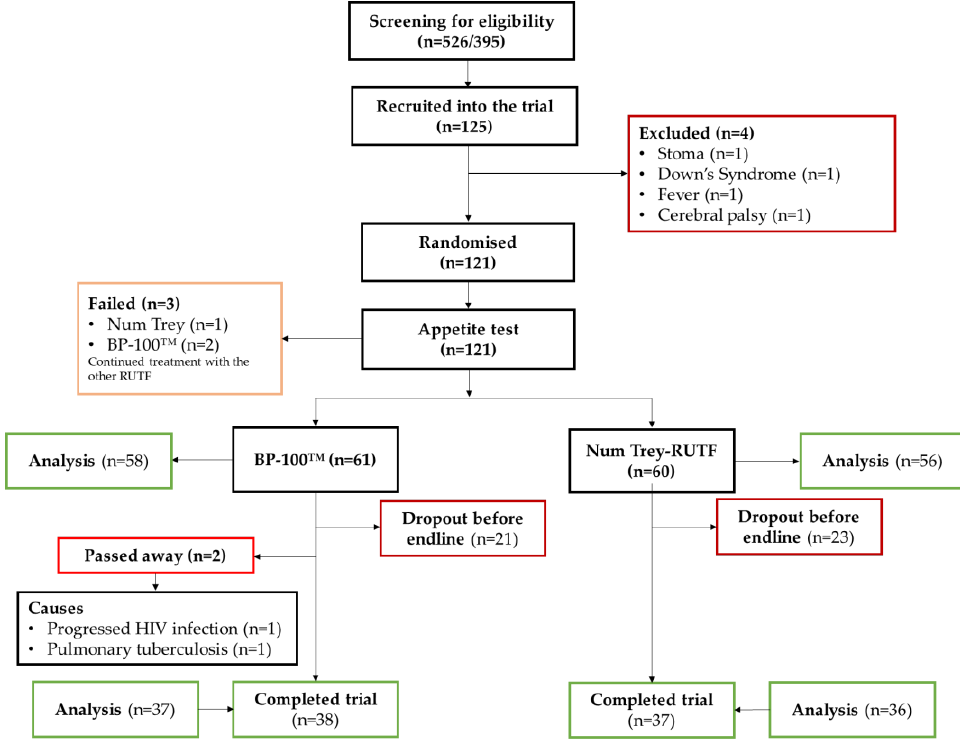
Figure 1. Flowchart of children enrolment into the trial. Table 3. Admission characteristics of children in each